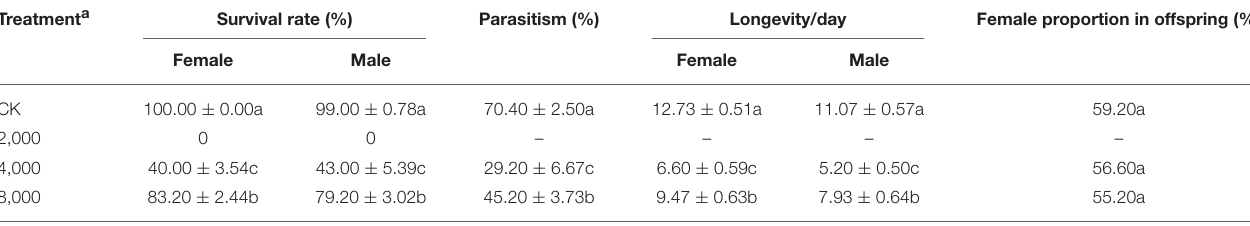
TABLE 1 | The side effects of IMD on the parasitism, longevity, and female proportion in offspring of A. gifuensis . Treatment a